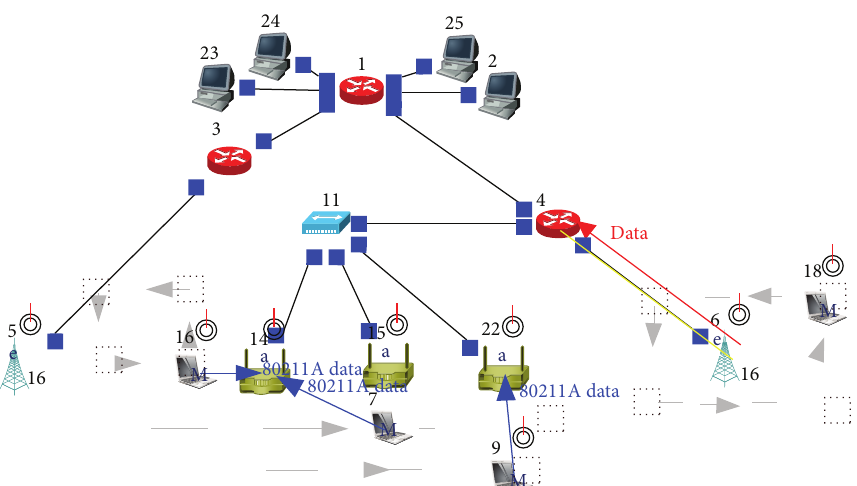
Figure 11: Screenshot from simulator with conventional